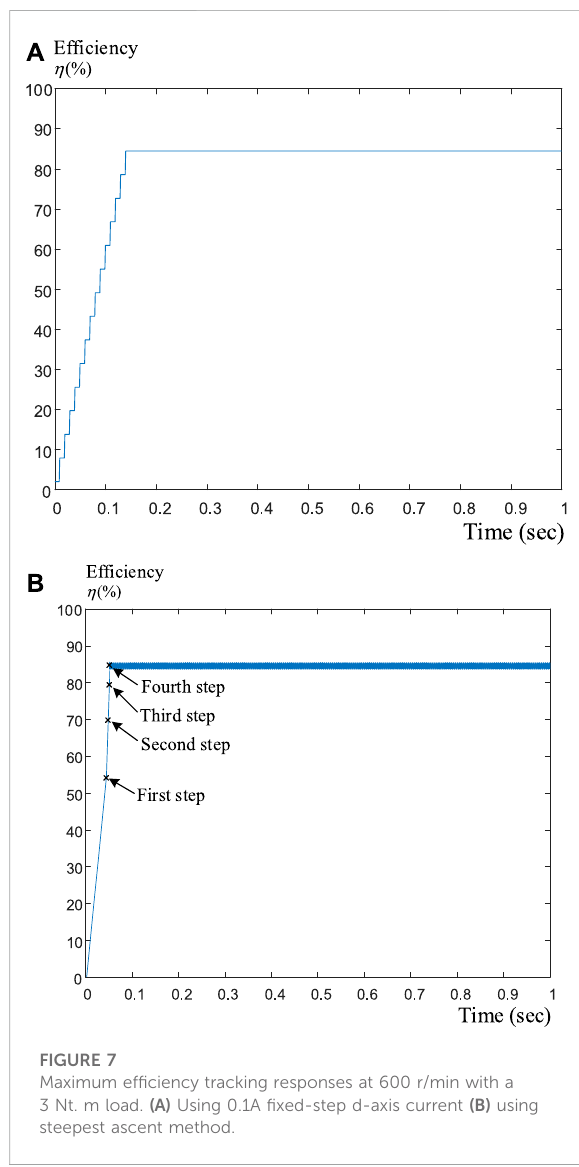
FIGURE 7 Maximum ef fi ciency tracking responses at 600 r/min with